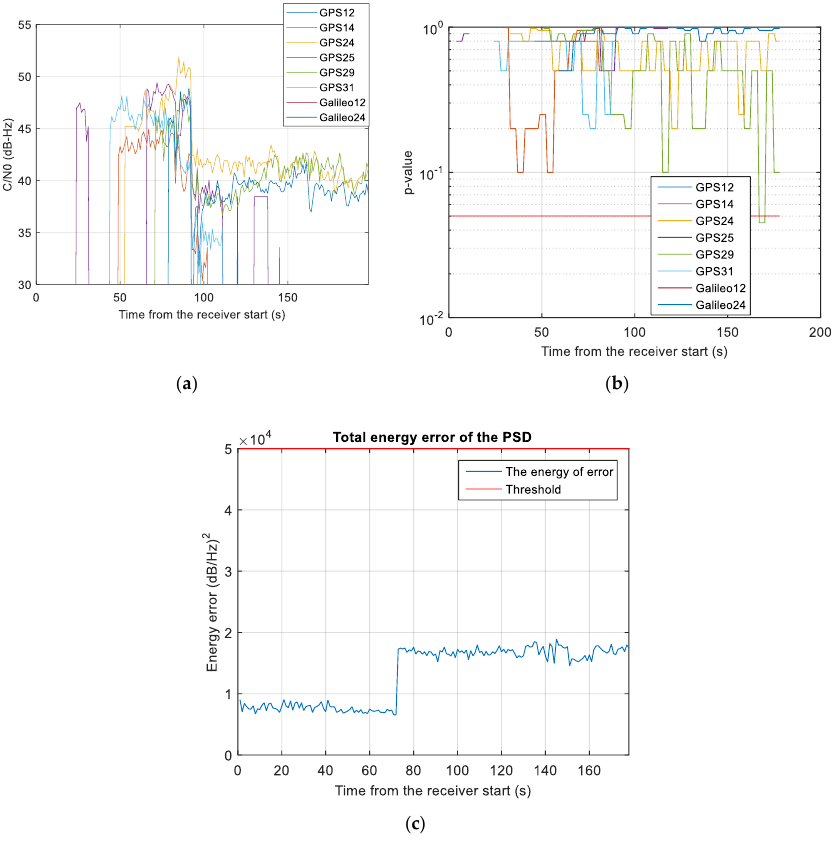
Figure 17. Analysis of the anomaly from the USRP: ( a ) C/N 0 and ( b ) GoF p -values estimated for different PRNs, and ( c ) total energy error of the PSD.